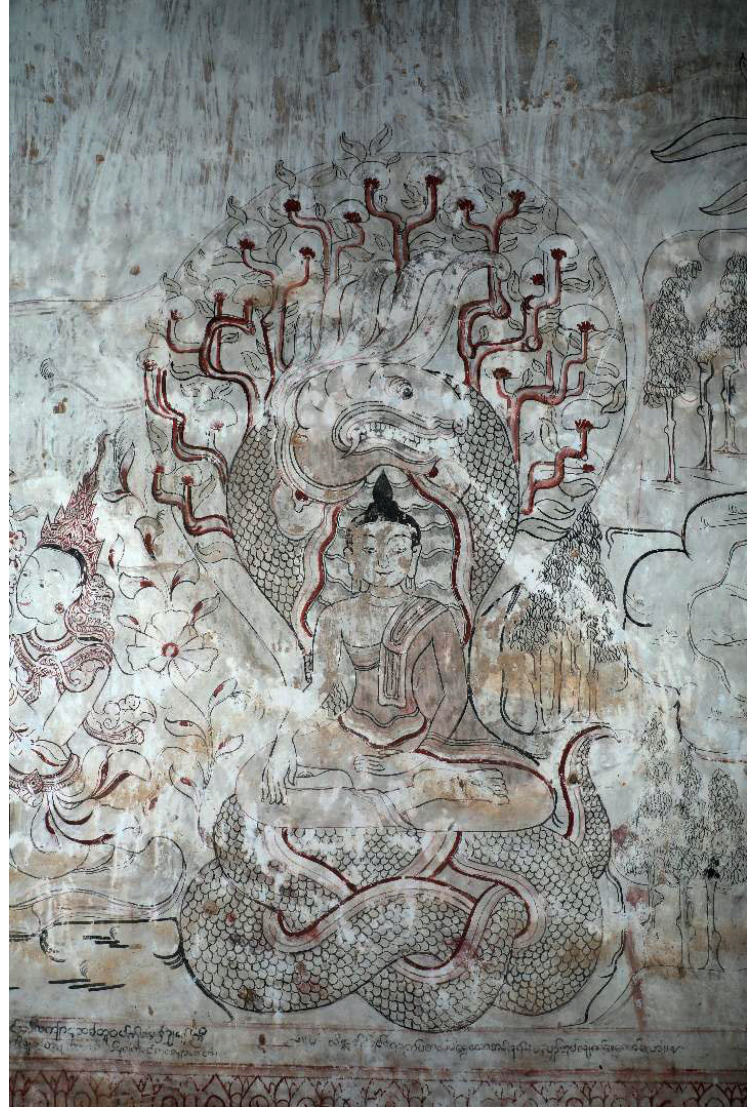
Figure 7. Mucilinda, the snake-king, protecting the Buddha from a torrential downpour, the Sixth Week, Sulamani temple, Bagan.